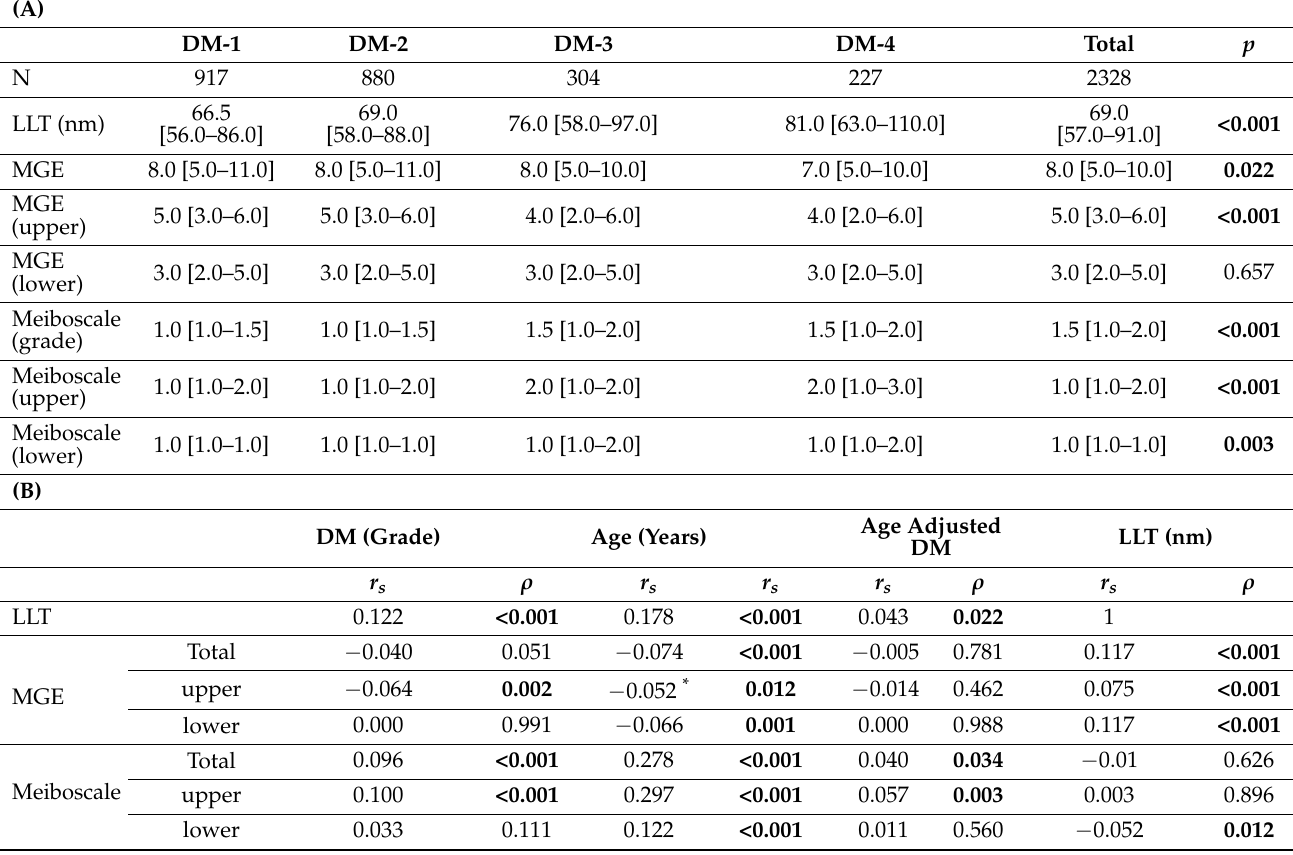
Table 3. Summary and correlations of meibomian gland-associated parameters. (A)Summary of meibomian gland-associated parameters according to dermatochalasis severity. (B) Correlations between dermatochalasis severity and lipid-related parameters.